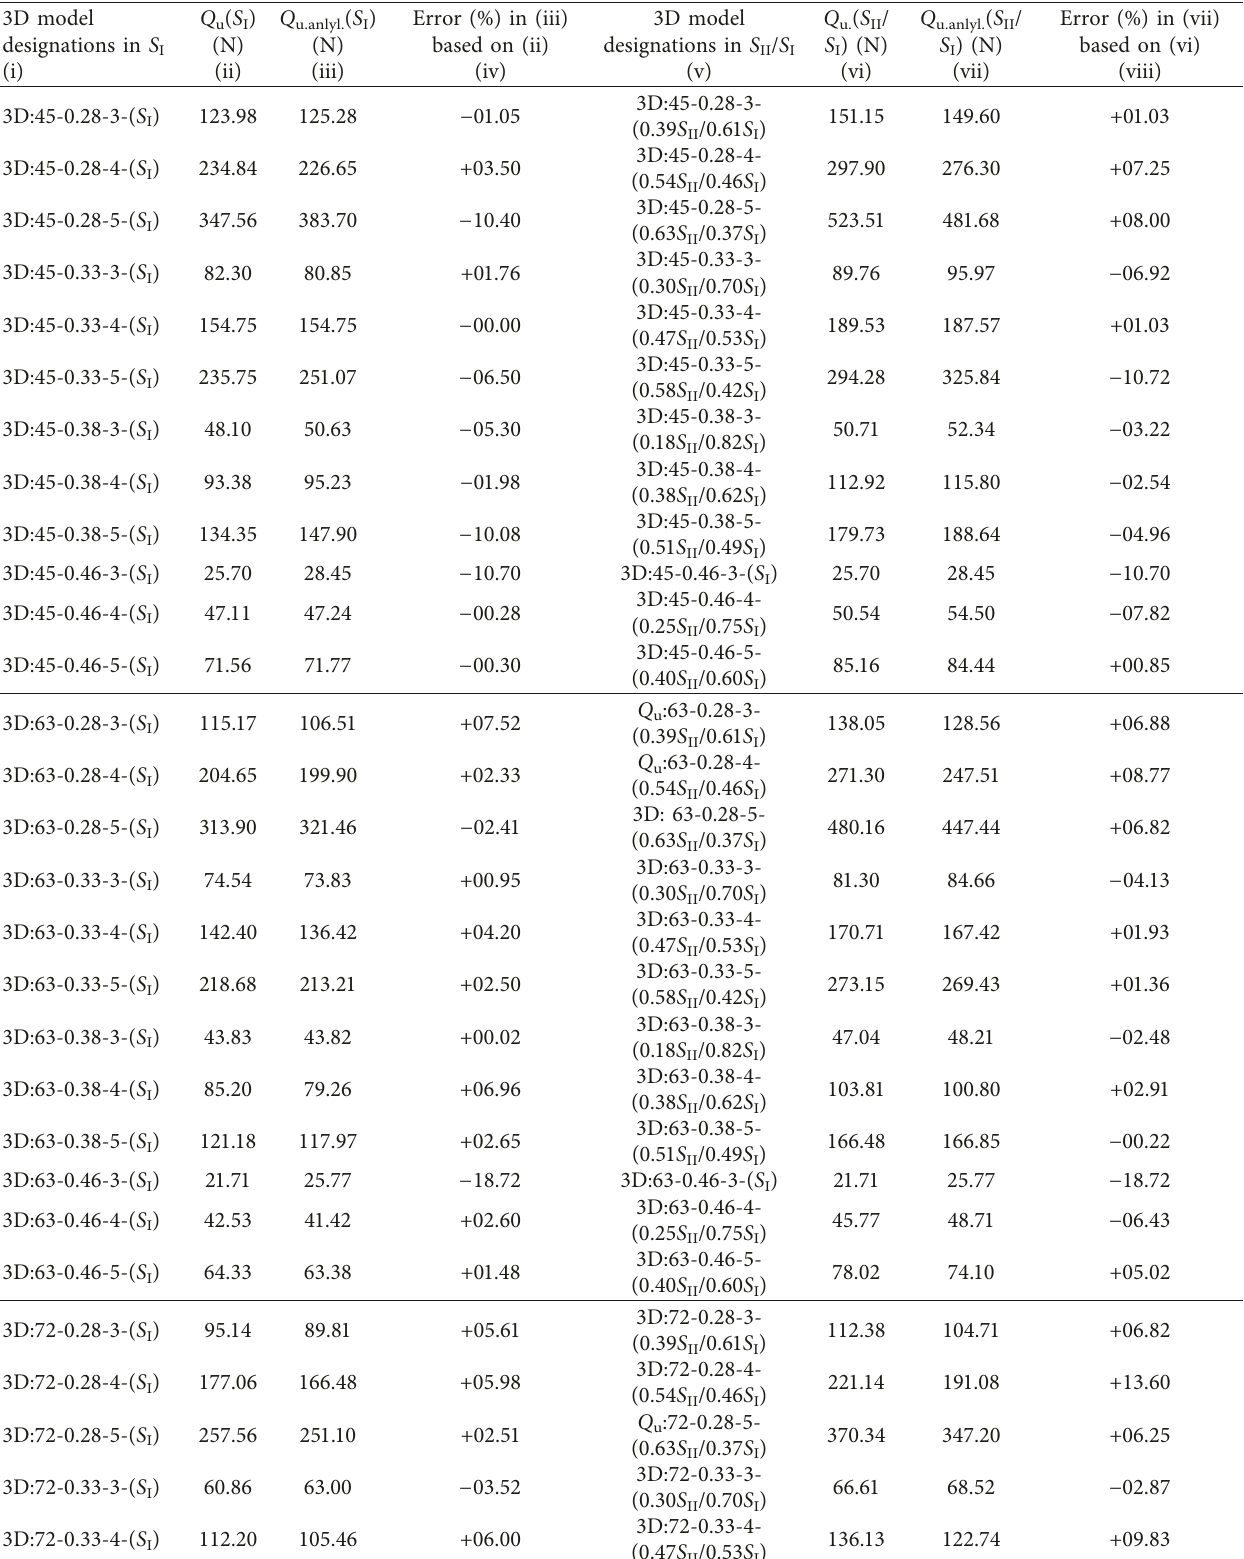
Table 4: Values of experimental uplift capacities in S I and S II / S I ( Q u ( S I ) and Q u ( S II / S I )), analytical uplift capacities in S I and S II / S I ( Q u.anlyl. ( S I ) and Q u.anlyl. ( S II / S I )), error (%) on Q u.anlyl. ( S I ) based on Q u ( S I ), and error (%) on Q u.anlyl. ( S II / S I ) based on Q u ( S II / S I